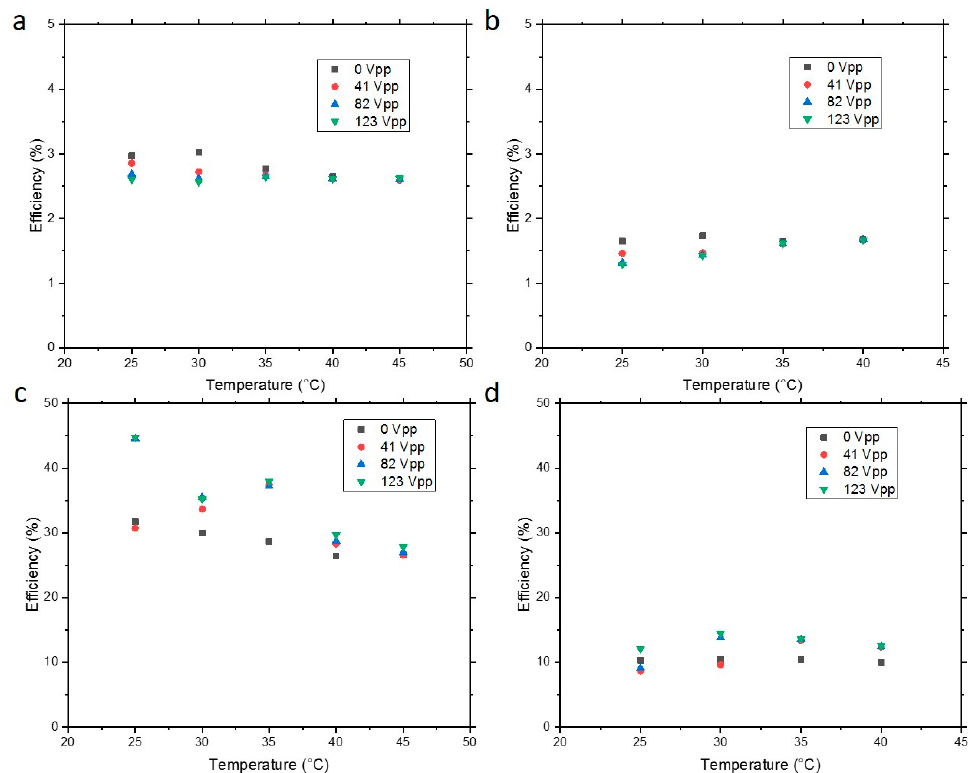
Figure 4. External power efficiency at different temperatures and applied electrical fields of a planar cell filled with ( a ) Dye 1; ( b ) Dye 2. Internal optical efficiency at different temperatures and applied electrical fields of a planar cell filled with ( c ) Dye 1; ( d ) Dye 2.